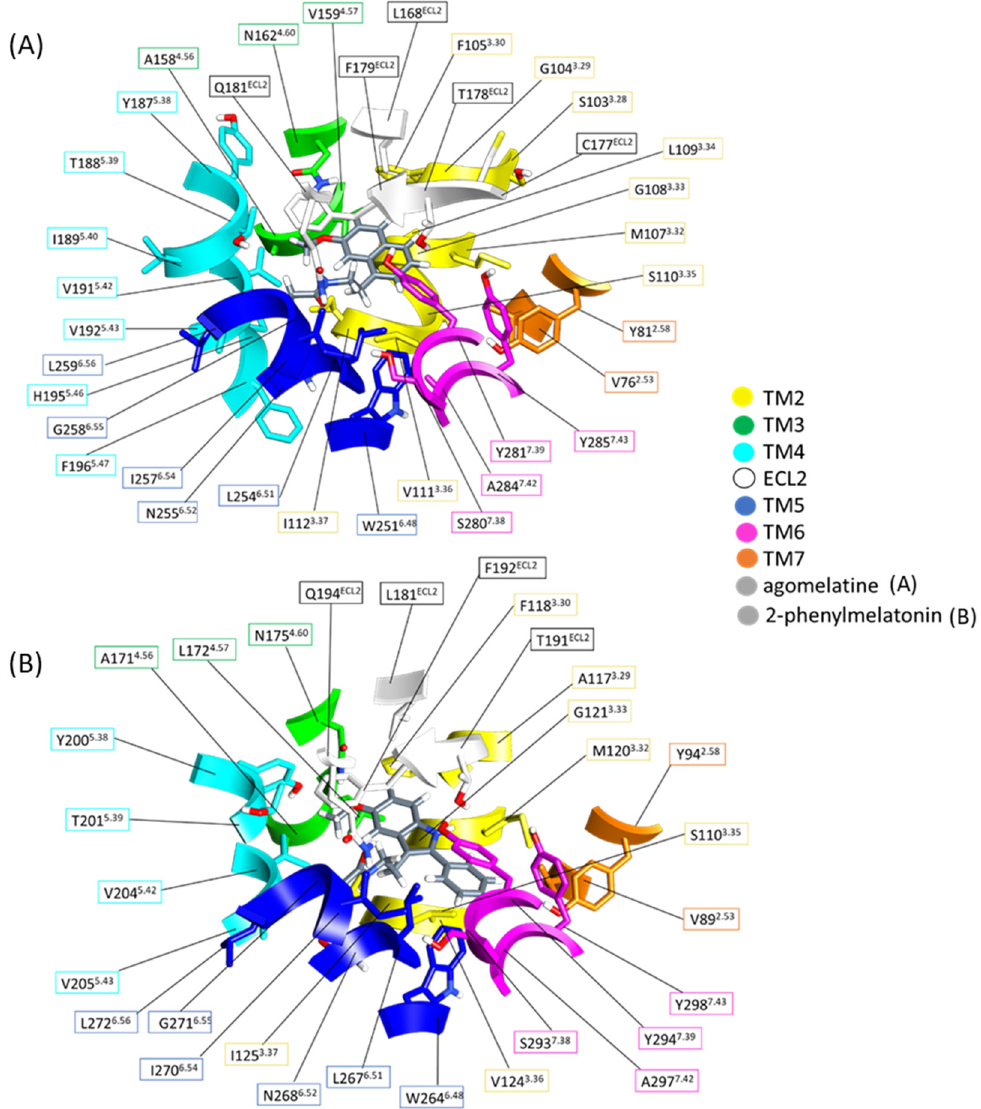
Figure 3. Residues at the orthosteric site of hMT1 ( A ) and hMT2 ( B ), binding agomelatine (with the same pose in 6ME5) and 2-phenylmelatonin (with the same pose in 6ME6). Each color indicates the receptor domain. TM: transmembrane domain, ECL: extracellular loop.